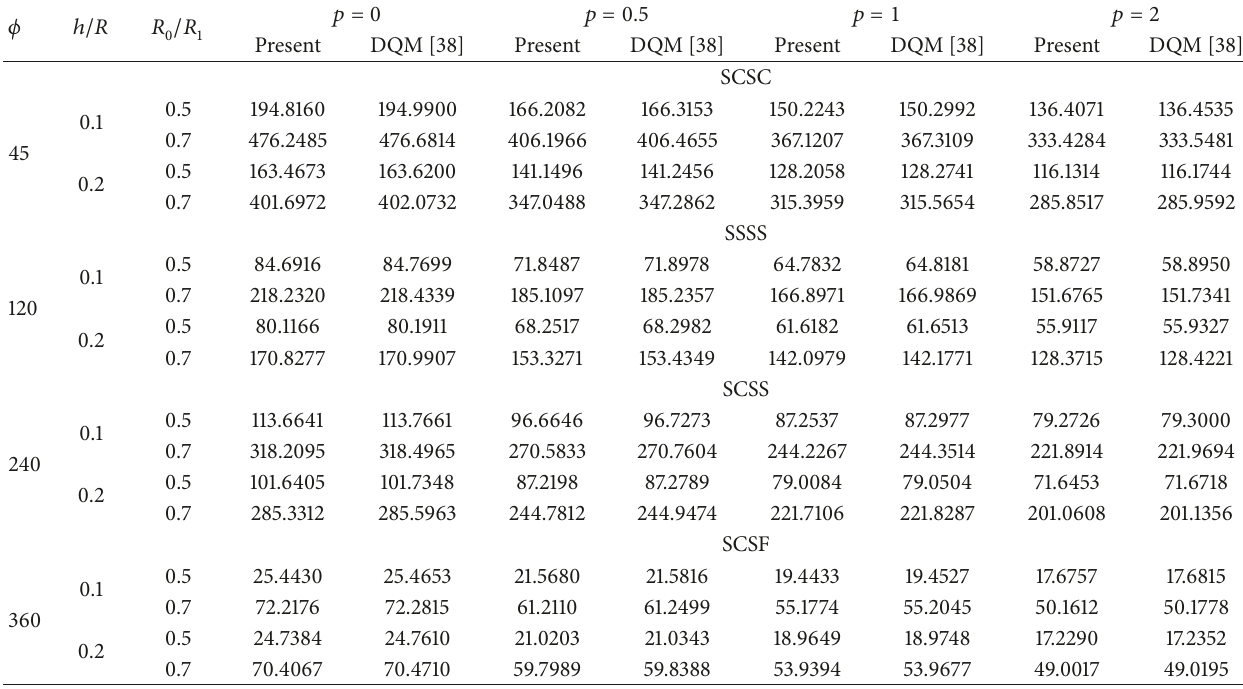
Table 3: Comparison of the fundamental frequency Ω for Type 1-1 (1-0-0) annular sector plate with different boundary conditions and some values of 𝑝 , 𝜙 , ℎ/𝑅 , and 𝑅 0 /𝑅 1 .